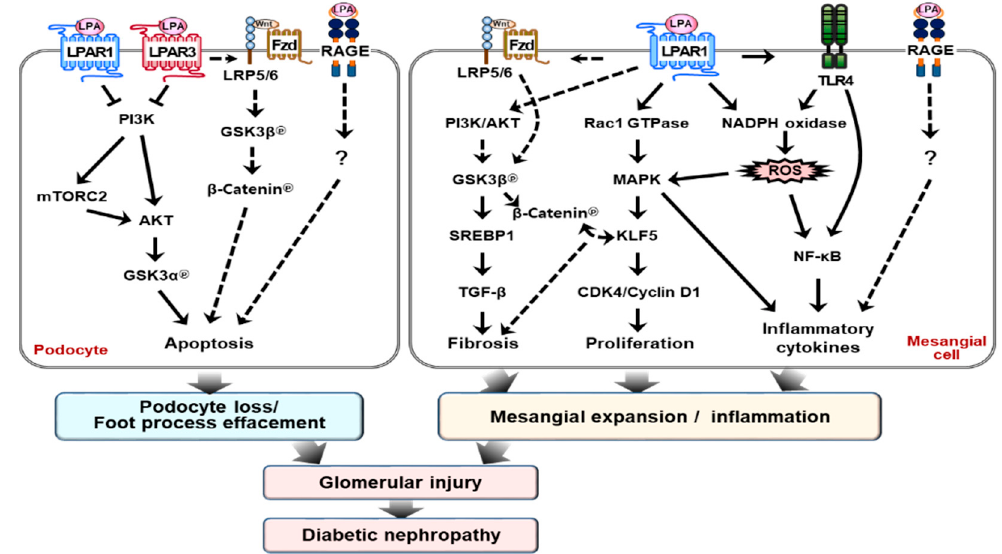
Figure 3. Schematic representation of LPA signaling in diabetic nephropathy models.